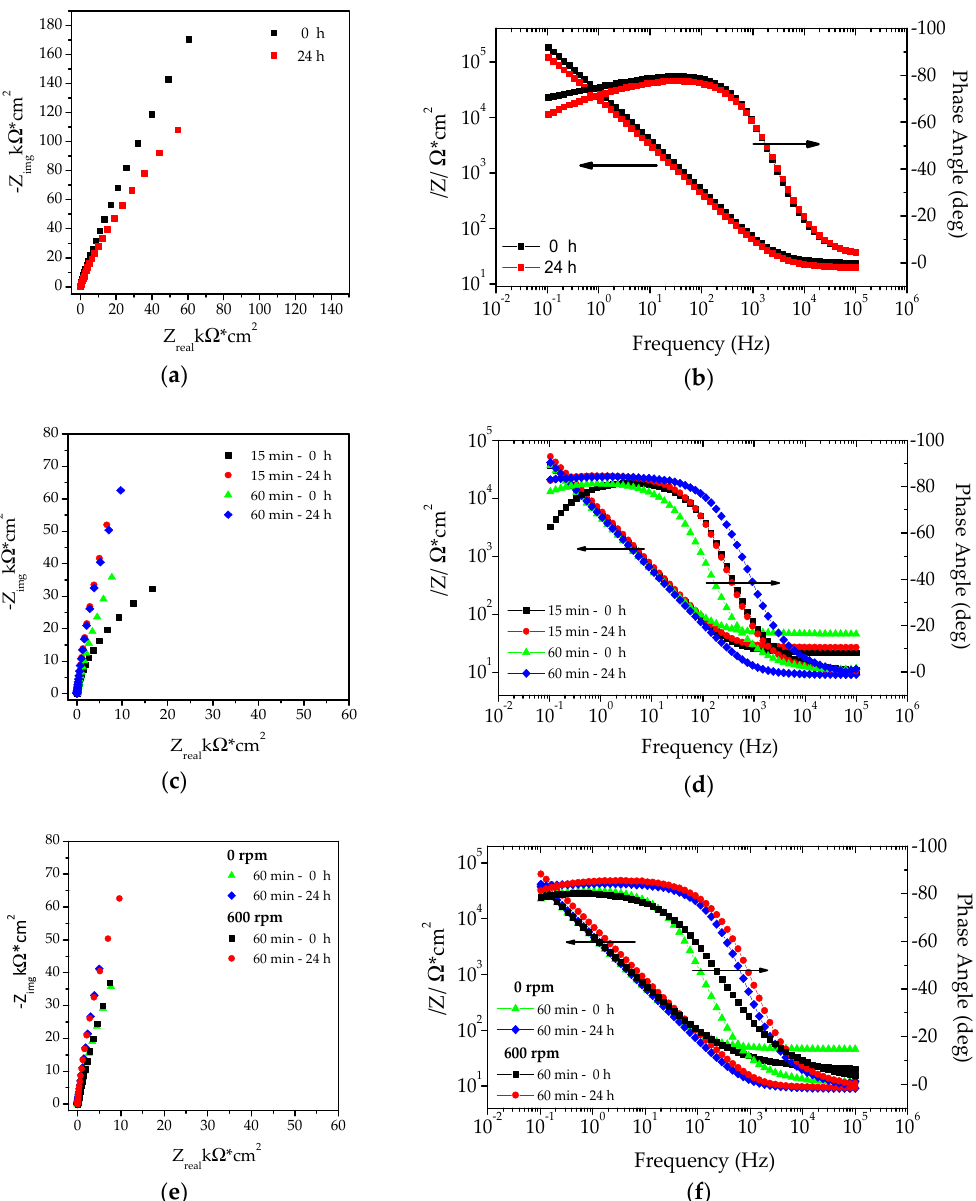
Figure 7. Electrochemical Impedance Spectroscopy (EIS), Nyquist and Bode diagrams at 0 and 24 h of immersion times; ( a , b ) corresponding to the non-anodized specimen; ( c , d ) anodization treatments at 15 and 60 min a 0 rpm; ( e , f ) effect of stirring speeds at 60 min of anodization.